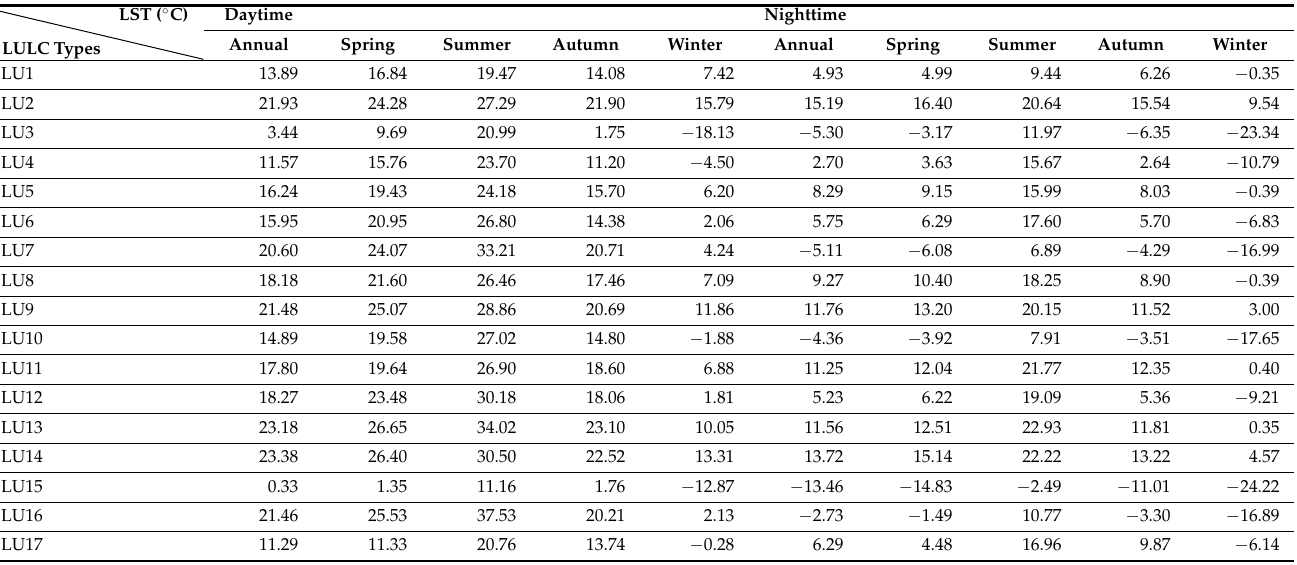
Table 3. Mean land surface temperatures (LSTs) of different land use/ land cover (LULC) types in the day and night, in each season and